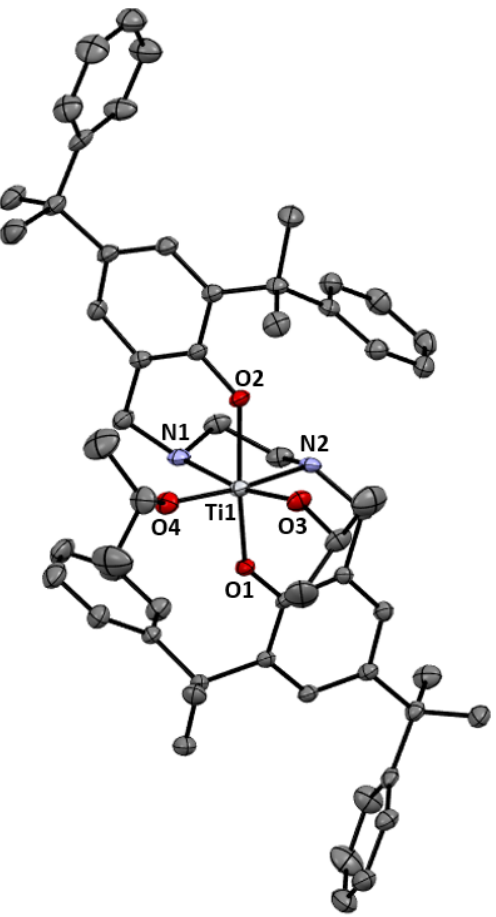
Figure 2. ORTEP diagram of [(H 2 N 2 O 2 )Ti(O i Pr) 2 ], 5 , showing thermal ellipsoids at 40% probability level. Hydrogens atoms were omitted by clarity. Selected bond lengths (Å) and angles (°): Ti(1)-N(1) 2.267(2), Ti(1)-N(2) 2.277(2), Ti(1)-O(1) 1.902(2), Ti(1)-O(2) 1.911(2), Ti(1)-O(3) 1.809(2), Ti(1)-O(4) 1.788(2); N(1)-Ti(1)-N(2) 75.74(8), N(1)-Ti(1)-O(4) 93.25(8), N(2)-Ti(1)-O(3) 87.76(8), O(3)-Ti(1)-O(4)